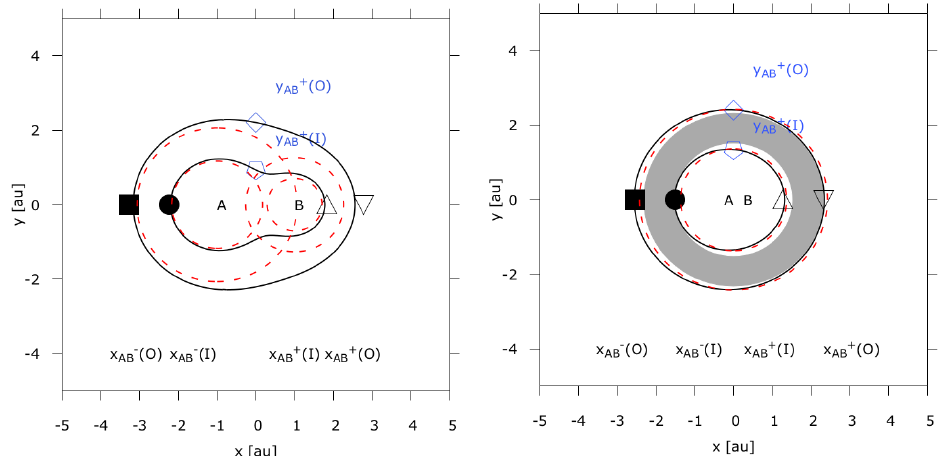
Figure 6. Isophote-based habitable zones and radiative habitable zones for close binary star configurations (P-type). The graphs are for configurations similar to α Centauri only on circular orbits with distances d = 3 au (left panel) and d = 0.5 au (right panel). The inner and outer borders of the single star habitable zone are given by red dashed lines. The red dashed lines in the right panel would represent the habitable zone, if both stars were located at the origin of the graph. The isophote-abscissa intersection points in the left panel are derived from Equations (15) and (16), whereas the ones on the right result from Equation (25), respectively. The radiative habitable zone vanishes for the system in the left panel. The closer system on the right has a radiative habitable zone shown in